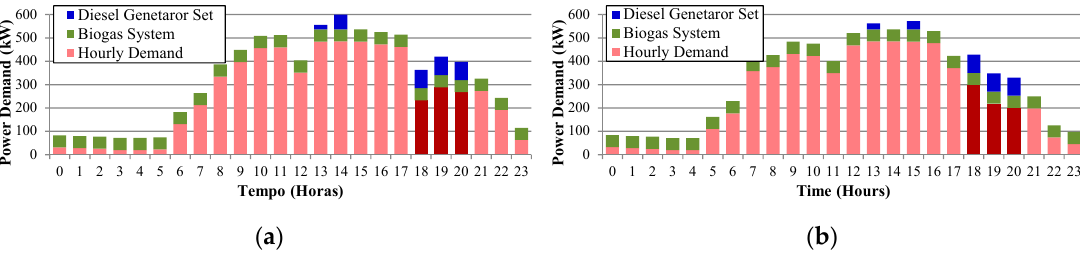
Figure 9. Graph using biogas and diesel generator set for: ( a ) March and ( b ) November.